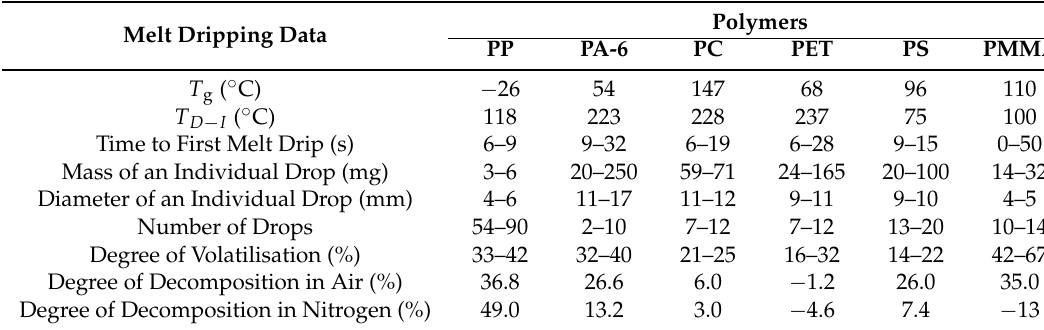
Table 1. Summary of melt dripping data obtained by Kandola et al.